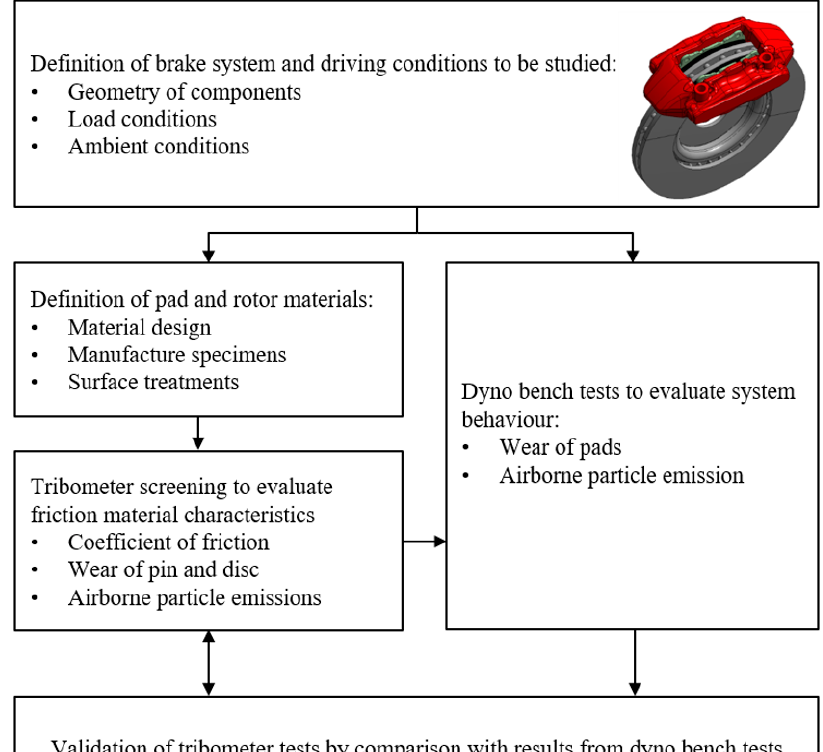
Figure 1. Experimental methodology with its validation routine.